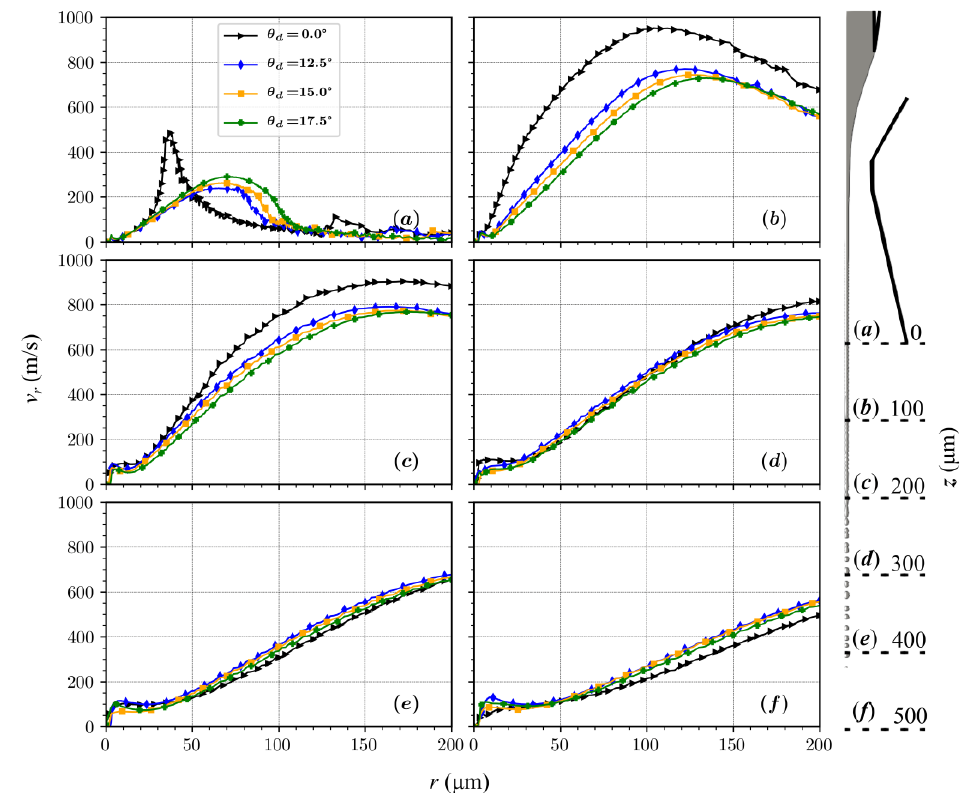
Figure 9. Radial component of velocity profile as a function of the radius at 6 axial positions for L d = 200 µm and diverging angles of 0°, 12.5°, 15°, and 17.5°.